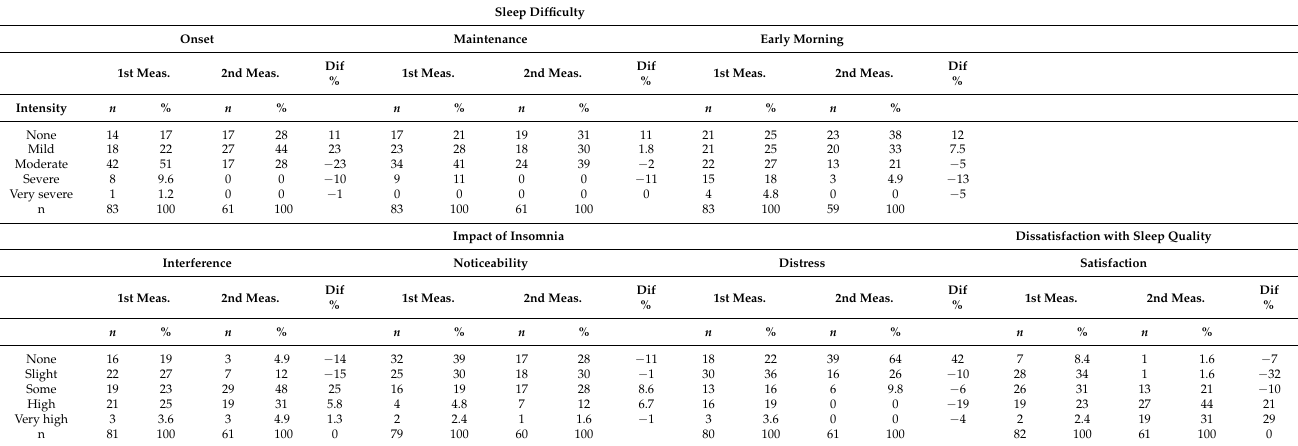
Table 3. Frequency of ISI